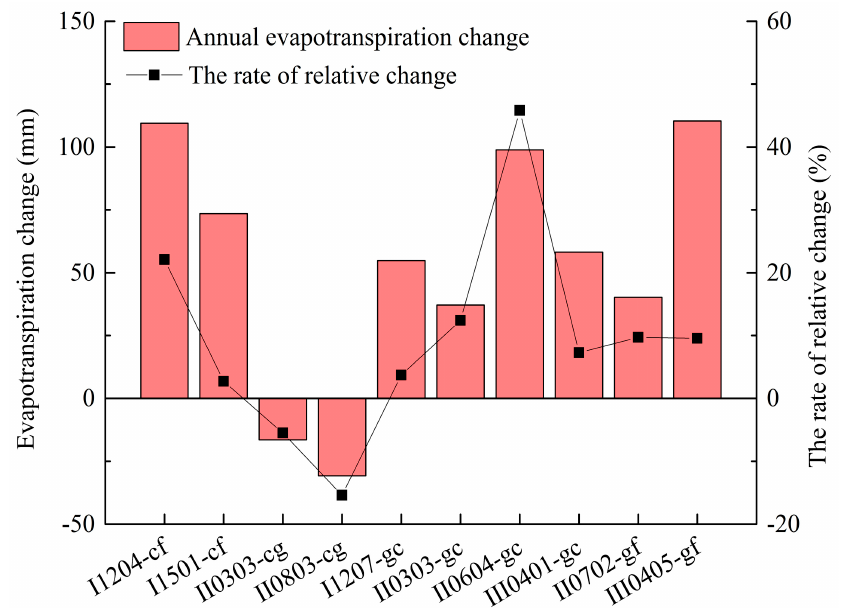
Figure 8. ET variation over typical vegetation changes from 2010 to 2020.